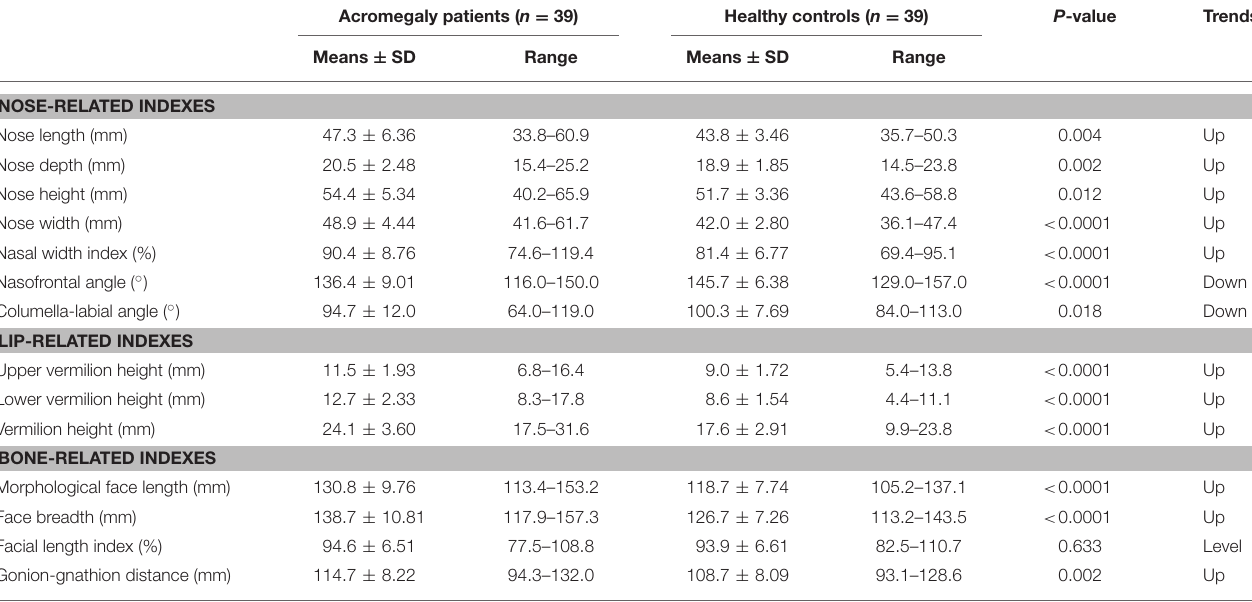
TABLE 2 | Quantitative facial changes of acromegaly patients compared with healthy controls.